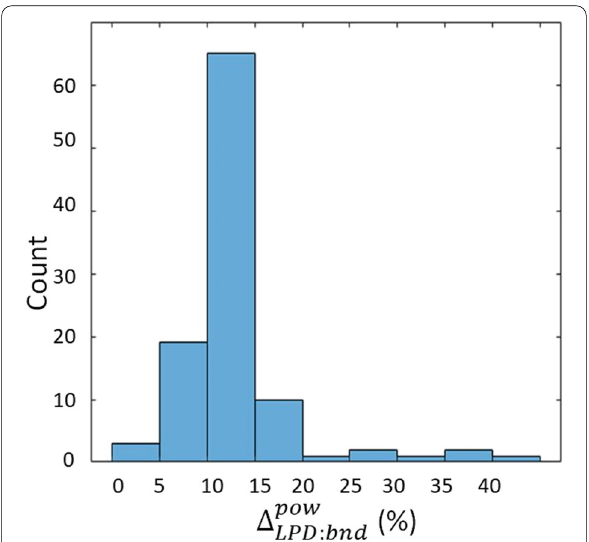
Fig. 6 Power by LPD vs P bound (all 104 models)